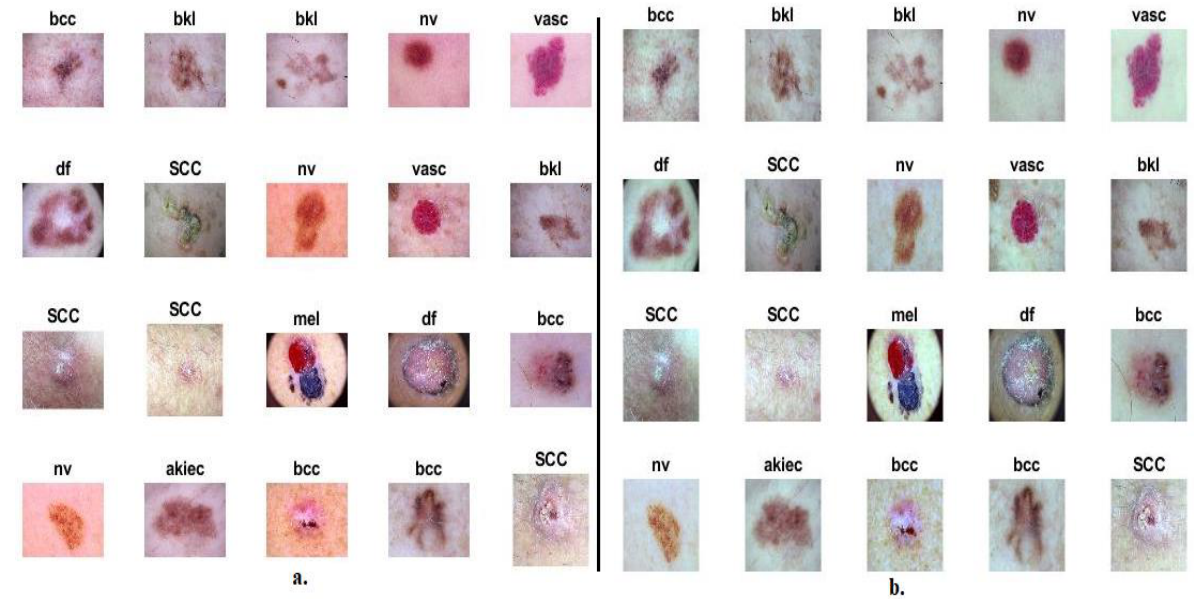
Figure 1. Sample dermatoscopy images of the ISIC 2019 dataset ( a ) before improvement ( b ) after improvement.